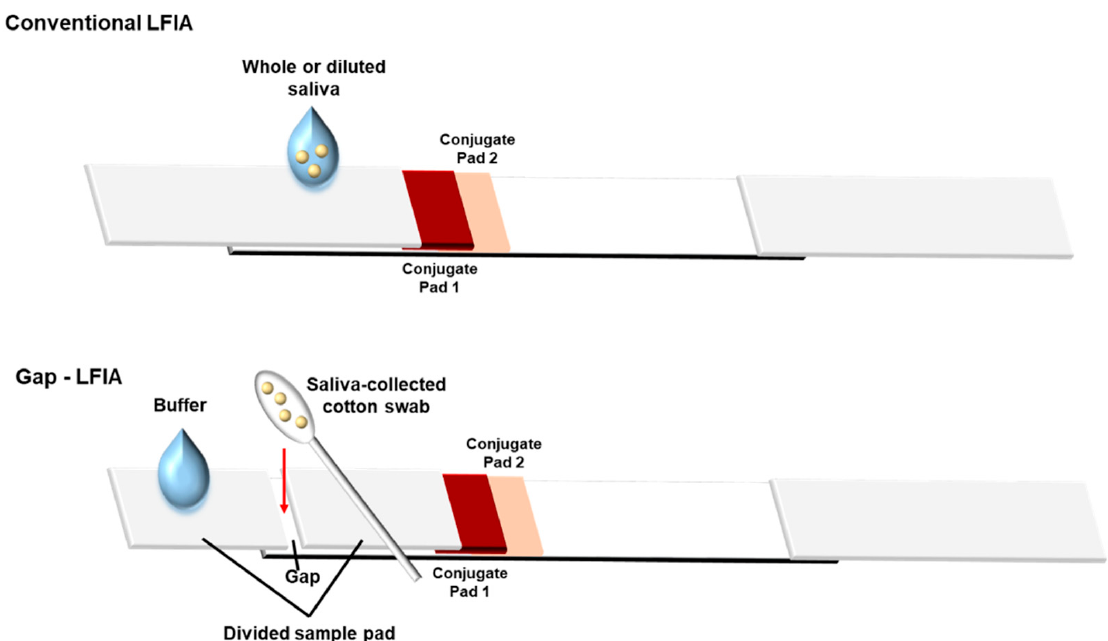
Figure 1. Structure of “gap-LFIA” with a saliva-collected cotton swab for detection of salivary cotinine compared to the conventional LFIA. The saliva is collected directly from the mouth and applied to the gap-LFIA. The cotton swab is inserted into the gap formed by the divided sample pads and allowed to connect.